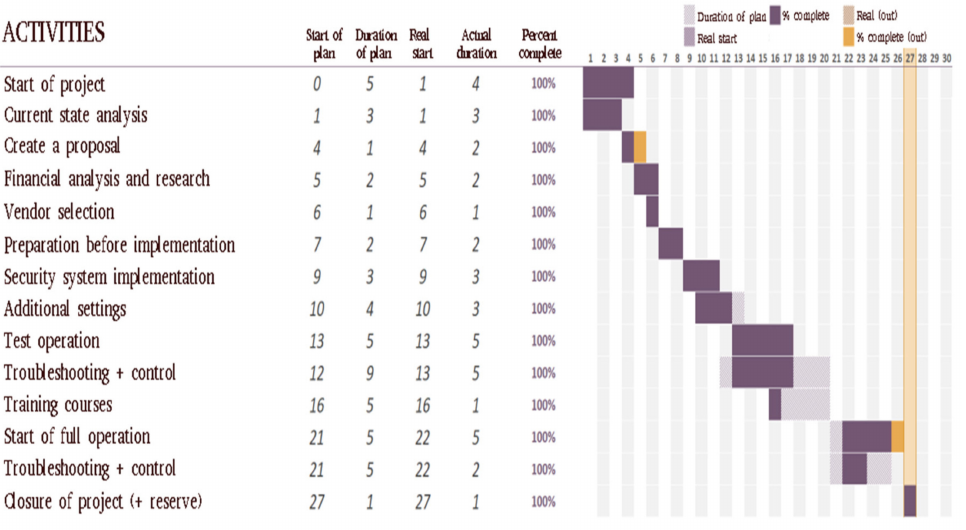
Figure 10. Gantt chart after project completion. Source: custom